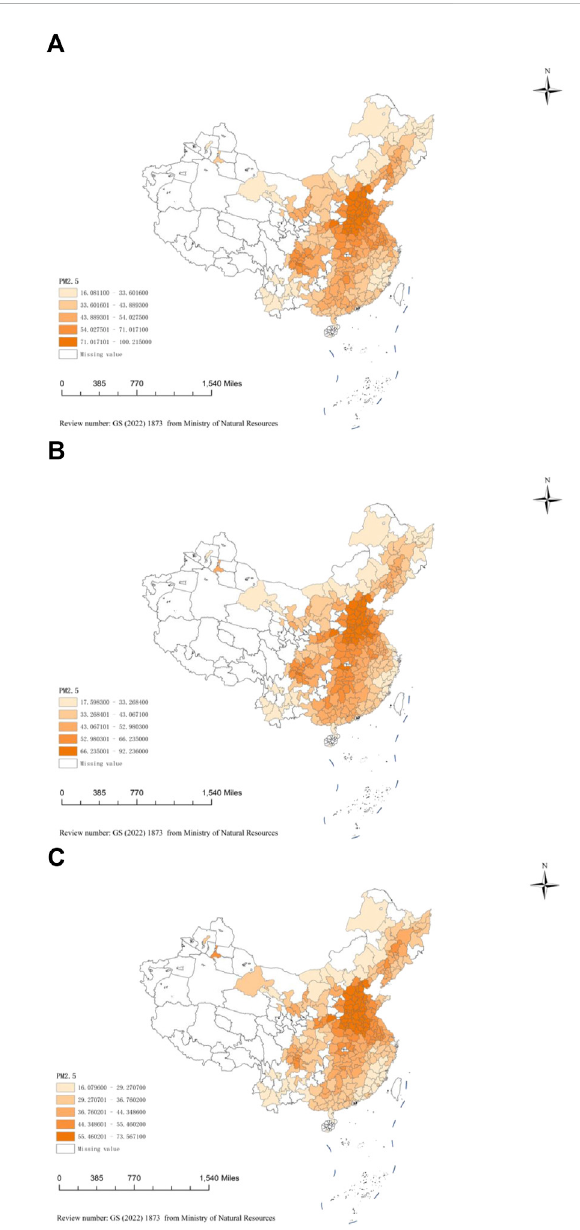
Spatial distribution of PM 2.5 concentration in China. (A) denotes the mapsin2006, (B) denotesthemapsin2011,and (C) denotesthemapsin 2017.